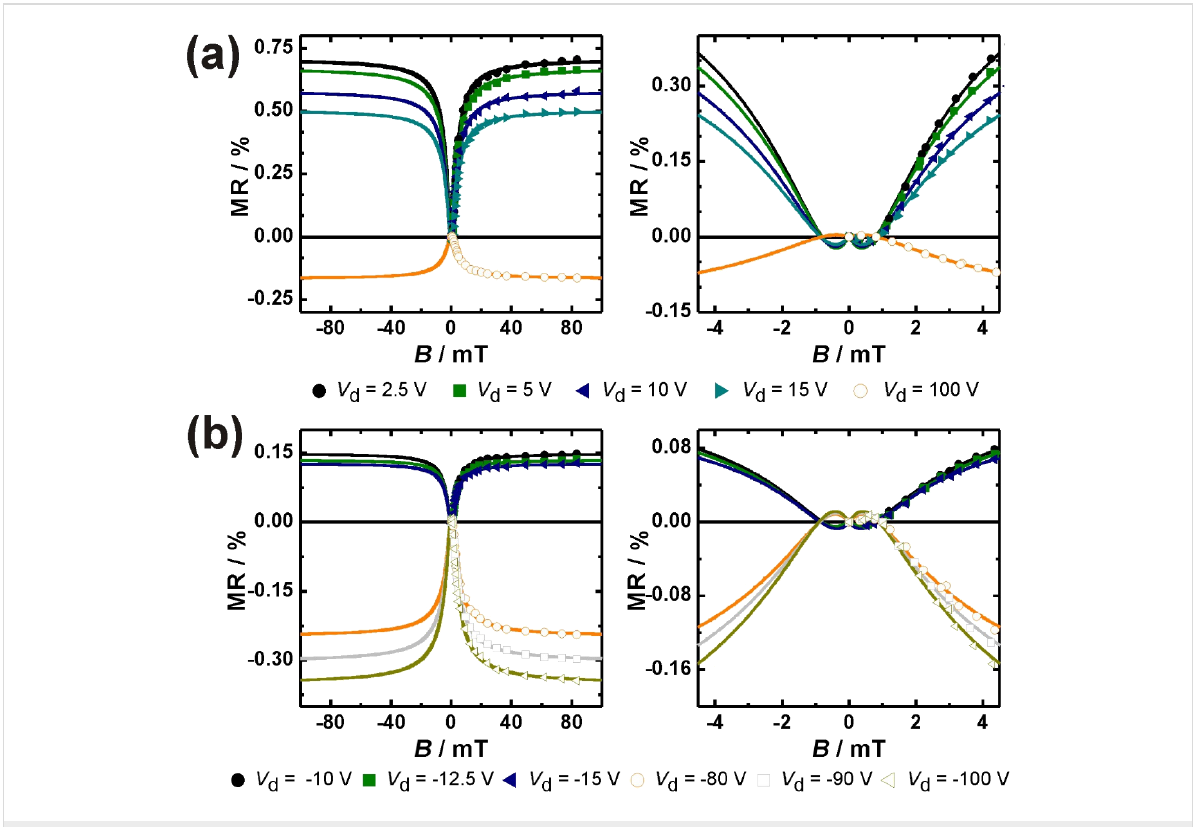
Figure 9: Magnetic-field effects in transistors based on different composition of Spiro-TTB and HAT-CN with a mixed ratio of (a) 51:49 and (b) 78:22 measured at different values of V d are shown. The high quality of fit in the saturation regime can be seen in the left side. The right side gives evi- dence of sign reversal of magnetoresistance and the ultrasmall magnetic field effect. The solid lines are fitting curves according to Equation 1. All measurements were carried out at zero gate